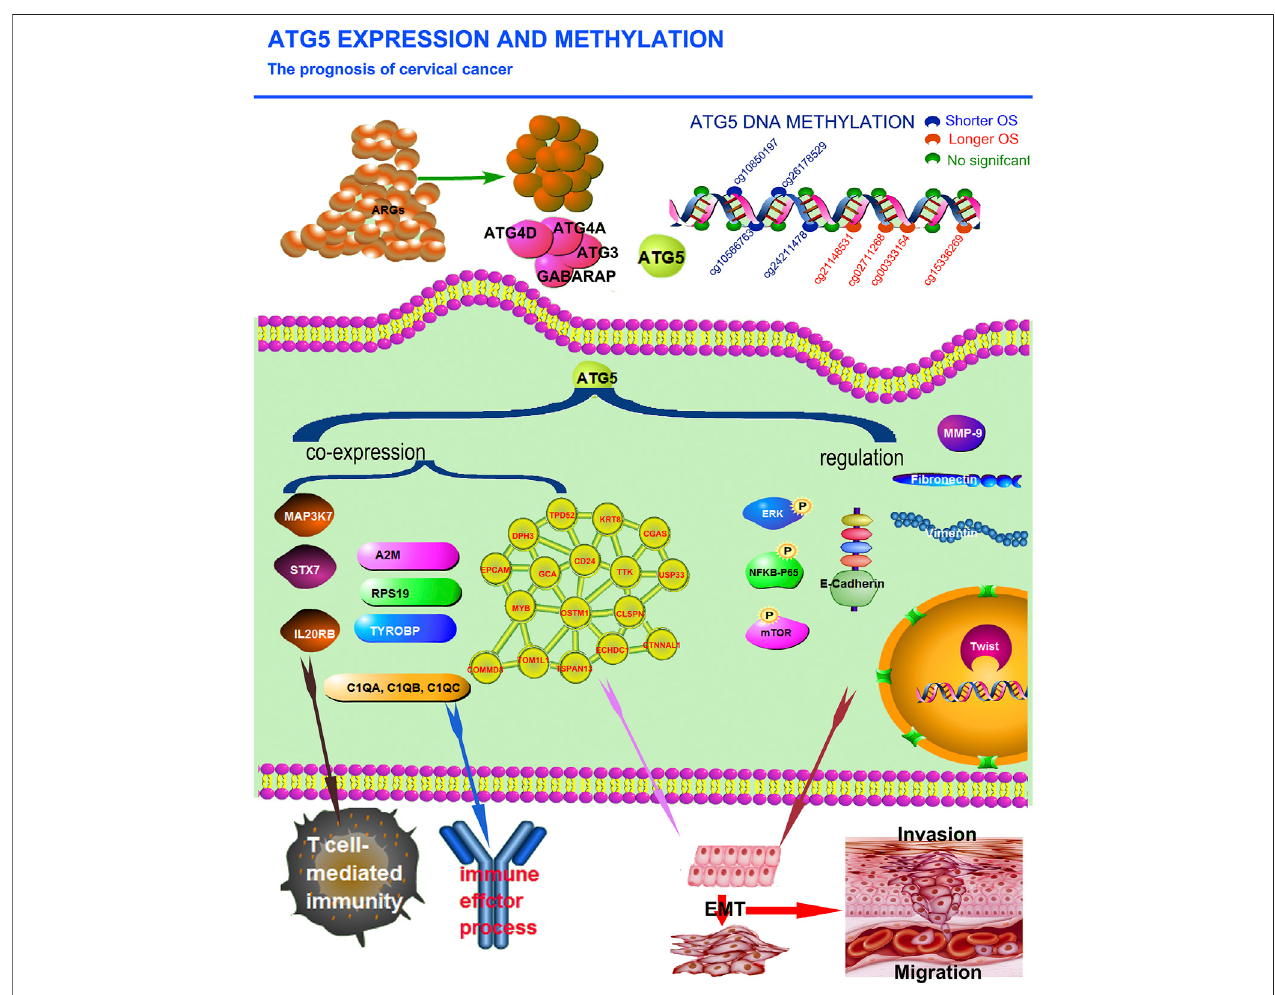
FIGURE 11 | The illumination of the effect of ATG5 expression and methylation in cervical cancer. ATG5 among these 32 ARGs was the most signi fi cant harmful factor affecting the prognosis of CESC patients. ATG5 co-expressed genes involved in the regulation of the immune effector process were A2M, C1QA, C1QB, C1QC, RPS19,MAP3K7, TYROBP, STX7, and IL20RB. And, MAP3K7, STX7, and IL20RB were in-volved in the regulation ofTcell-mediated immunity. Moreover,ATG5 might promote the migration and invasion of CESC by the regulation of N-cadherin, Vimentin, P-ERK, P-NF κ Bp65, P-mTOR, MMP-9, and Twist. ATG5 was also signi fi cantly correlated with EMT signature related genes including DPH3, CD24, KRT8, CTNNAL1, EPCAM, TSPAN13, MYB, TPD52, ECHDC1, CLSPN, USP33, TTK, TOM1L1, GCA, COMMD8, CGAS, and OSTM1. ATG5 methyltaion status also in fl uence CESC OS. Among these 19 methylation sites in ATG5, four sites signi fi cantly increased while other four sites signi fi cantly decreased OS of cervical cancer